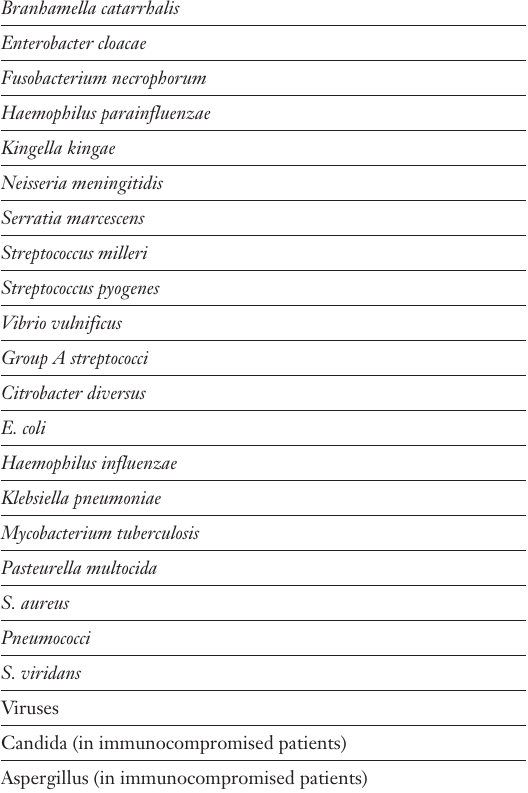
Organisms that can cause acute epiglotti- tis in adults [ 4, 13, 14, 20–28 ]